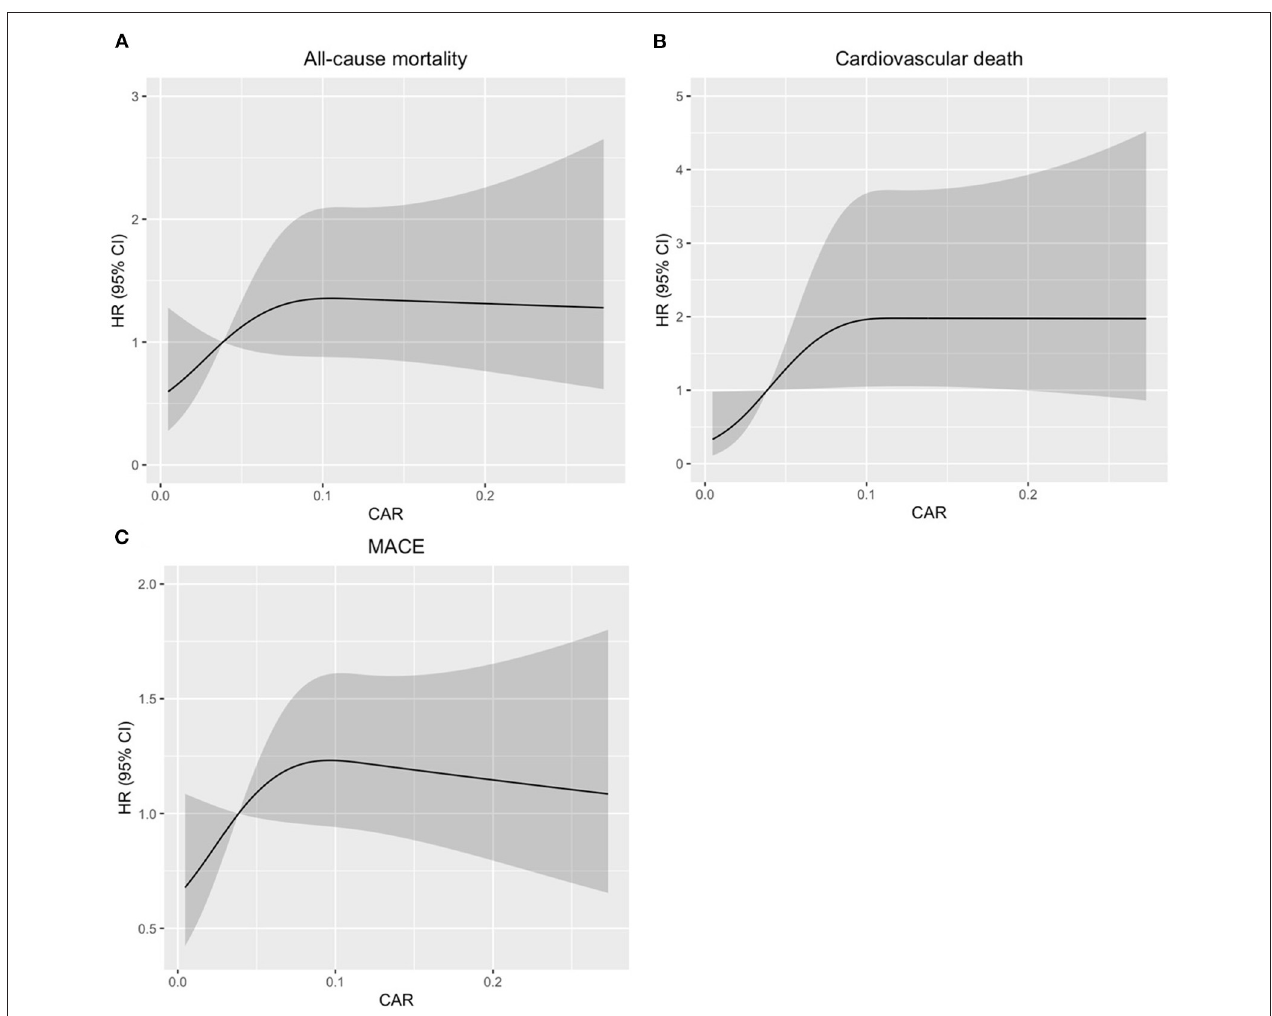
FIGURE 3 | Restricted spline curves for the associations between CAR and all-cause mortality, cardiovascular death, or MACE in patients with coronary total occlusion (CTO) undergoing percutaneous coronary intervention (PCI). Black lines represent the hazard ratio (HR), gray areas represent the 95% CIs. (A) , Association between CAR and all-cause mortality. (B) , Association between CAR and cardiovascular death. (C) , Association between CAR and MACE. The HR (95% CI) were all adjusted according to Model 3 in the Cox